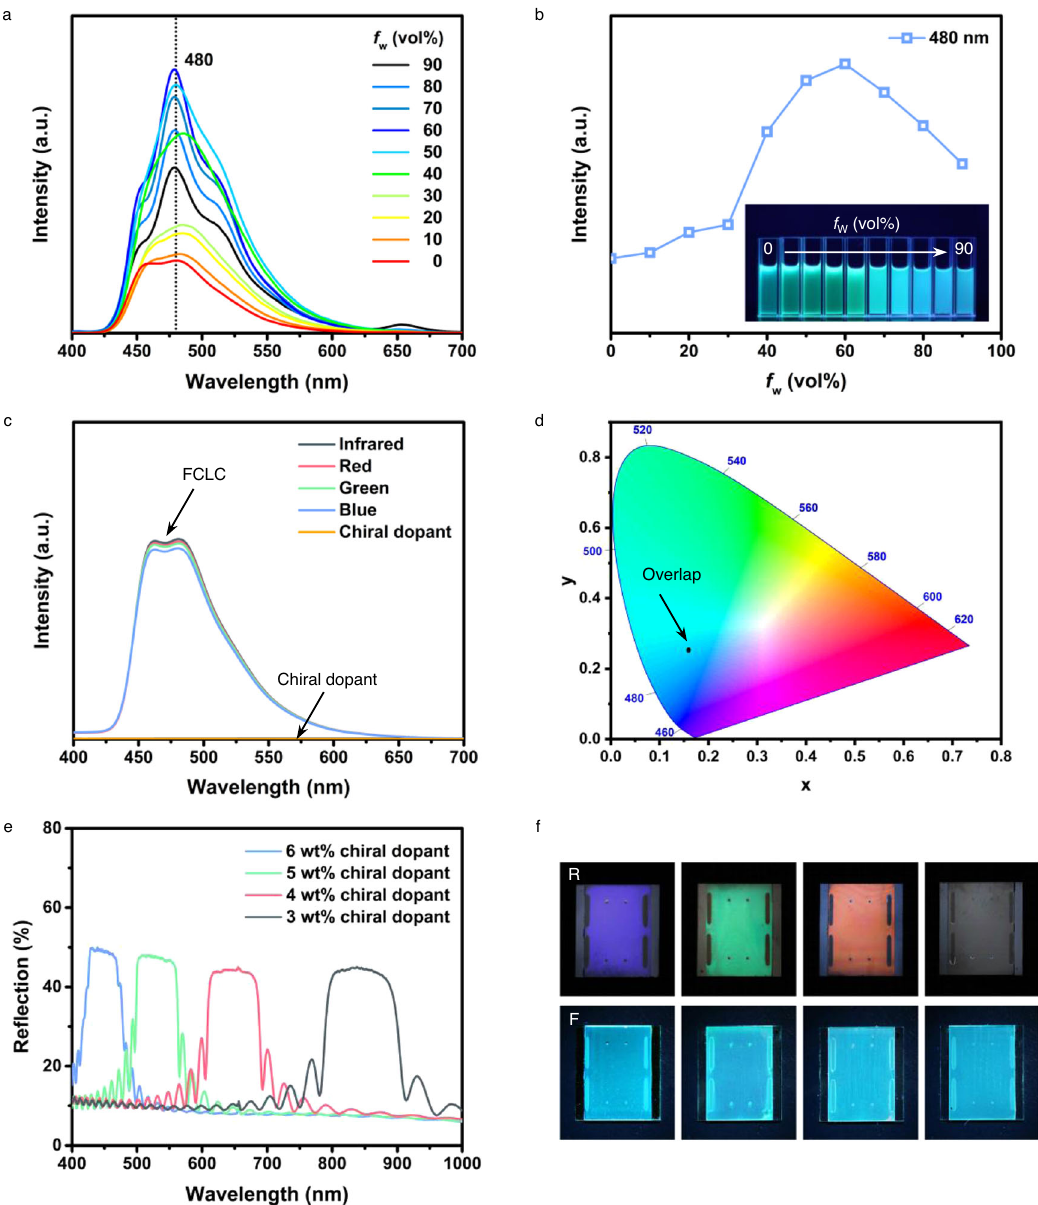
Fig. 2 Characterization of the FCLCs. a Photoluminescence (PL) spectra of DC5 in THF and THF/water mixtures ( c = 10 − 4 M). The excitation wavelength is 388 nm. b A Plot of the emission intensity at 480 nm versus water fractions ( f w ) for DC5 in THF and THF/water mixtures. The inset photograph shows DC5 in THF and THF/water mixtures ( f w increases from 0 to 90 vol%) upon UV irradiation. c PL spectra of FCLC mixtures containing 6, 5, 4, 3 wt% chiral dopants in THF ( c = 0.5 M) and chiral dopant in THF ( c = 10 − 4 M). d CIE chromaticity coordinates of different FCLC mixtures containing 6, 5, 4, 3 wt% chiral dopants in THF ( c = 0.5 M), which are (0.159, 0.251), (0.159, 0.252), (0.159, 0.254), and (0.159, 0.254), respectively. e Re fl ectance spectra of the FCLC mixtures containing 6, 5, 4, 3 wt% chiral dopants in 5 μ m thick antiparallel aligned cells. f Photographs of the FCLC mixtures containing 6, 5, 4, 3 wt% chiral dopants in 5 μ m thick antiparallel aligned cells to show blue, green, red, transparent (infrared) re fl ection colors and cyan fl uorescent color. R, re fl ection color under white light; F, fl uorescent color upon UV